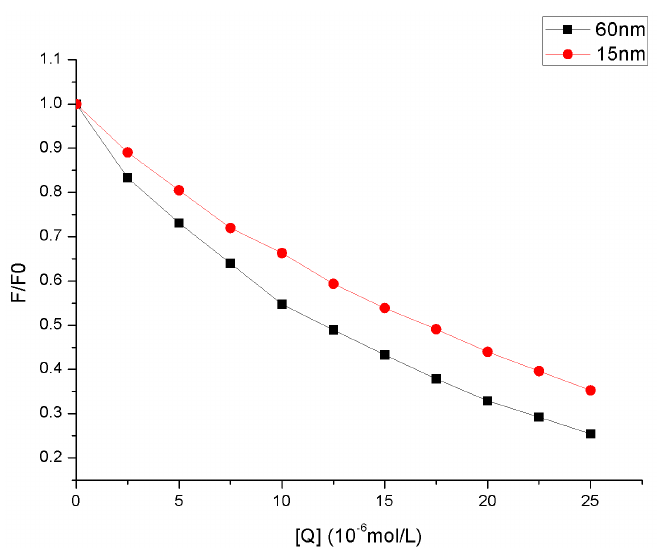
Figure 4. The quenching of HSA synchronous fluorescence by astilbin; C HSA = 2.5 × 10 − 6 mol · L − 1 . C astilbin (a → k): 0, 2.5, 5, 7.5, 10, 12.5, 15, 17.5, 20, 22.5, 25 × 10 − 6 mol · L − 1 .